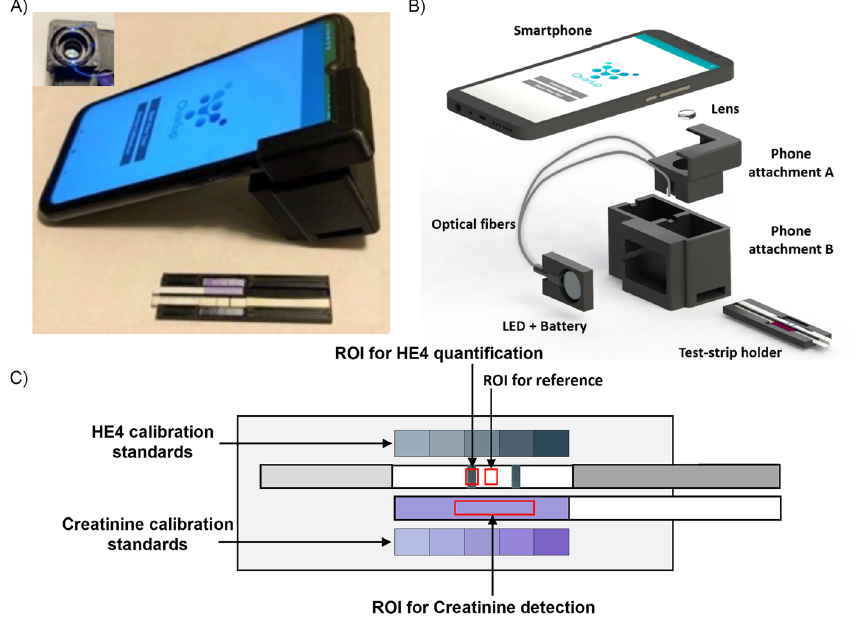
Figure 7. Overview of the smartphone quantification system. ( A ) Image of the prototype components (lens, cell phone attachments and strip cassette). ( B ) A CAD model providing an overview of the components used in developing the system. ( C ) Schematic of the test-strip holder indicating the color detection scheme and the red boxes (arrows) indicate the region of interest (ROI) for HE4, for background reference, and a ROI for